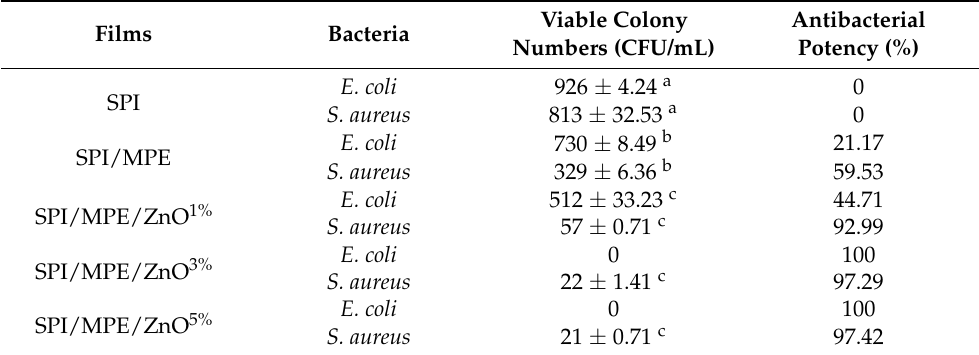
Table 2. Antimicrobial effect of SPI films.